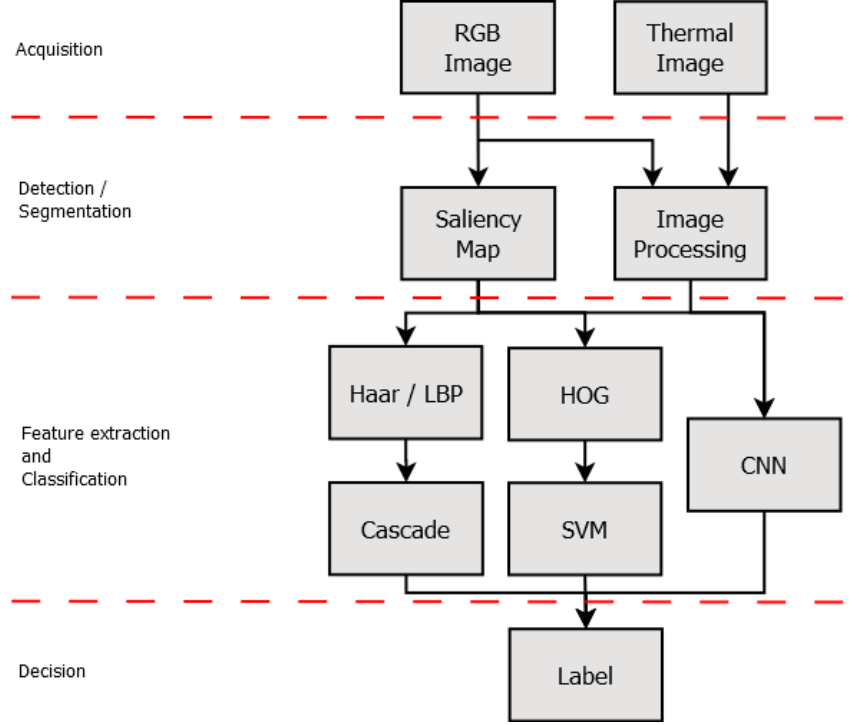
Figure 10. The pattern recognition systems used in this